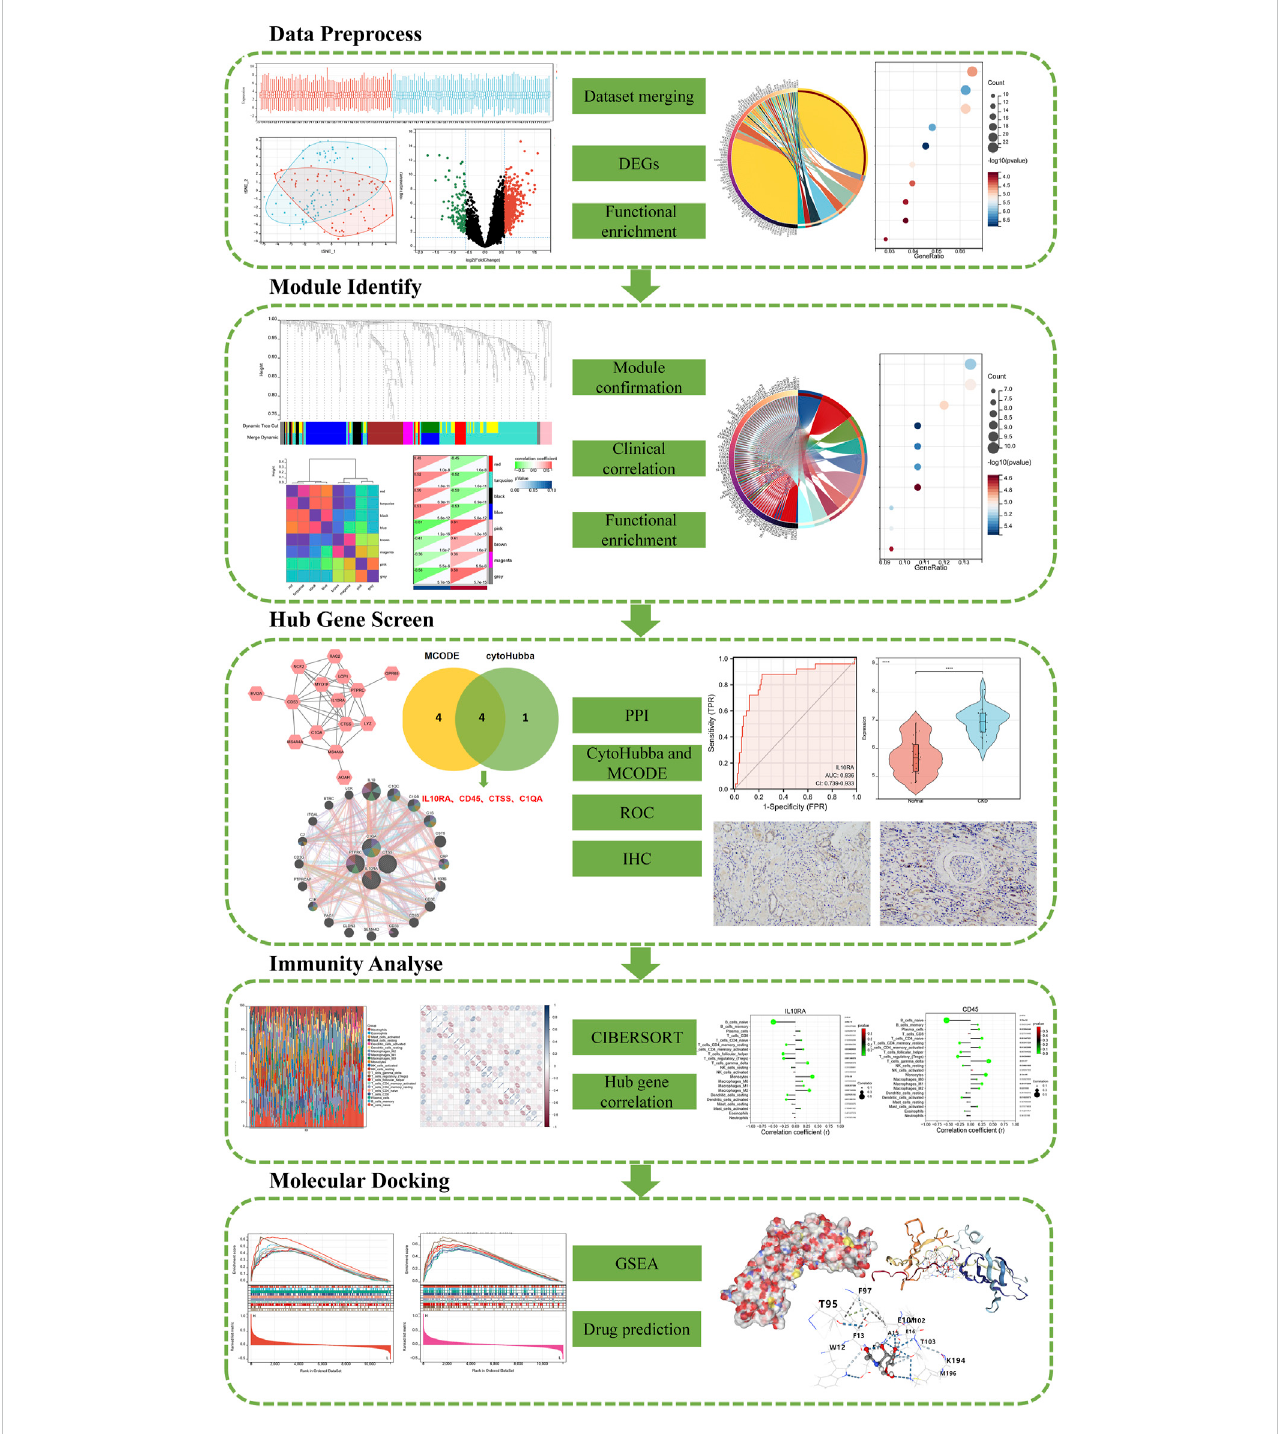
FIGURE 1 A schematic diagram based on a comprehensive method of bioinformatics analysis and validation experiment of CKD.